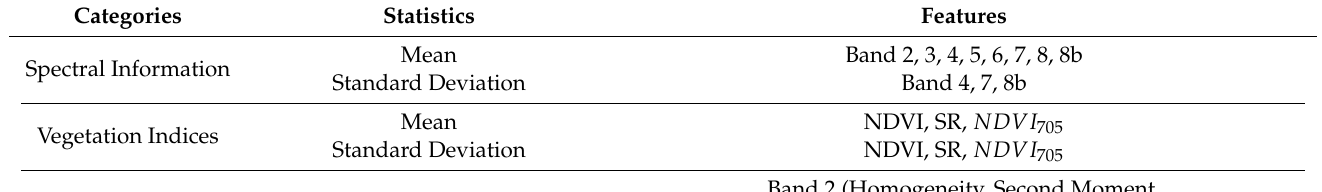
Table 5. Feature subset of multispectral and SAR bands, VIs, and textural features screened by RF_RFE.